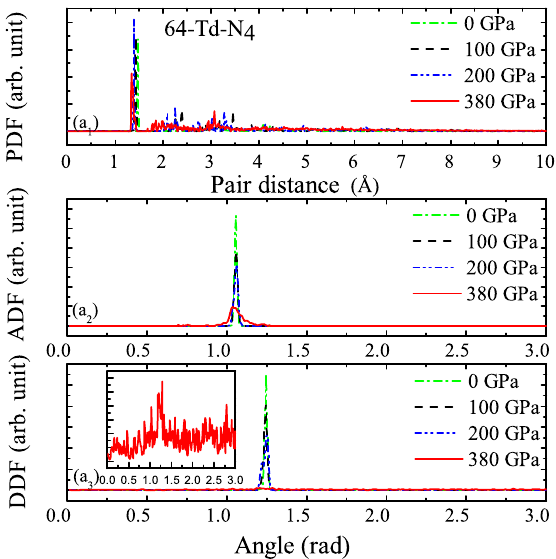
Figure 7. Pair distribution functions for 64-Td-N 4 under 0, 100, 200, and 380 GPa. ( a 1 ) Pair distribution function (PDF). ( a 2 ) Angle distribution function (ADF). ( a 3 ) Dihedral distribution function (DDF).